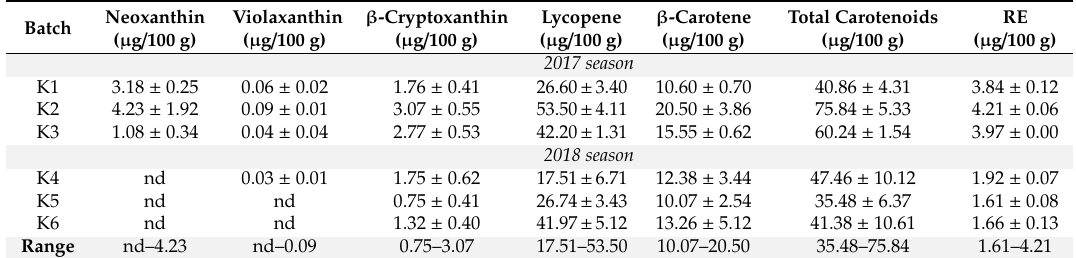
Table 5. Carotenoids content ( µ g / 100g fw) of deastringed persimmon fruits (‘Rojo Brillante’ variety) analysed in the 2017 and 2018 seasons. Results are expressed as mean ± standard deviation ( n –1), n =